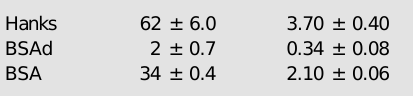
Table 2. Inhibition of E-BSAd phagocytosis by LPS-activated macrophages caused by treatment with tyrosine protein kinase inhibitors. Inhibitor Percent inhibition